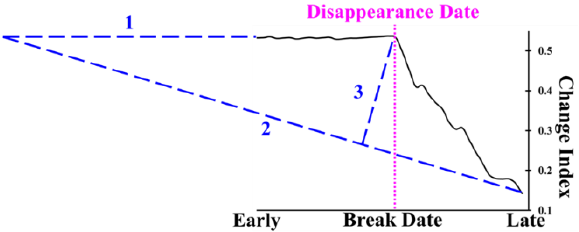
Figure 4. Change index sequence pertaining to